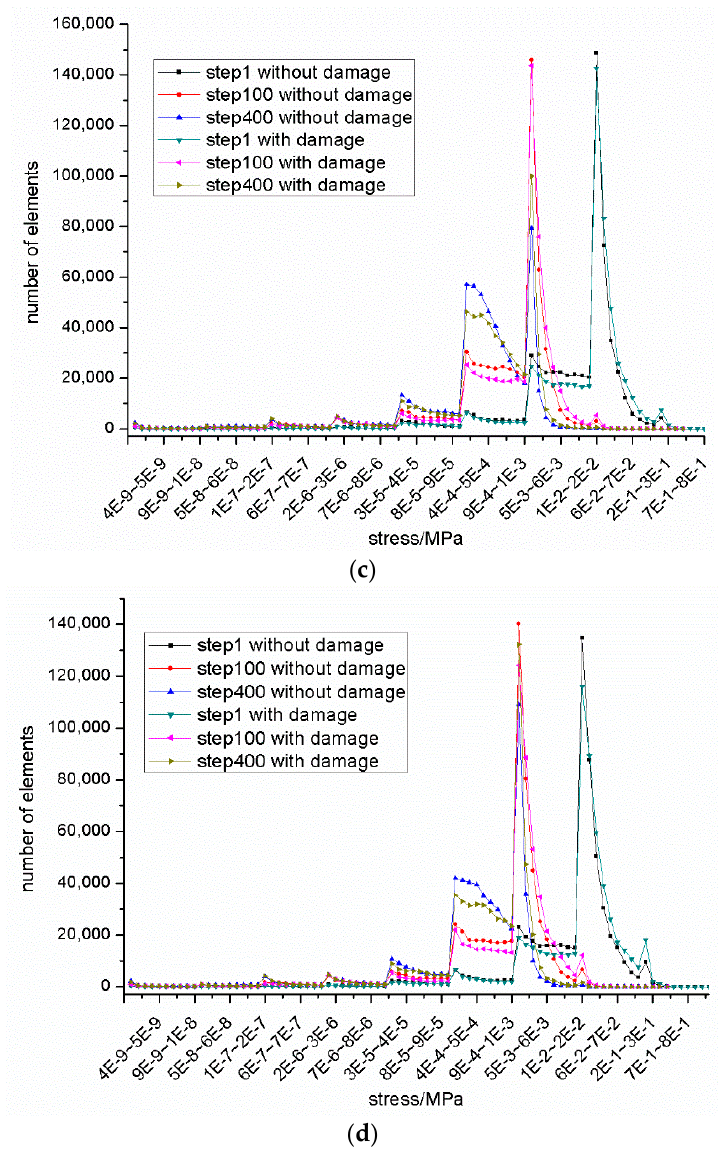
Figure 10. The von Mises stress in the whole specimen: ( a ) 10 μ ɛ with and without damage; ( b ) 20 μ ɛ with and without damage; ( c ) 50 μ ɛ with and without damage; and ( d ) 70 μ ɛ with and without damage.